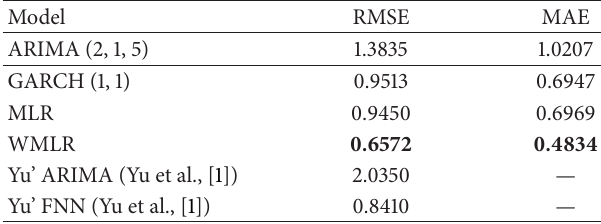
Table 3: The RMSE and MAE comparisons for different